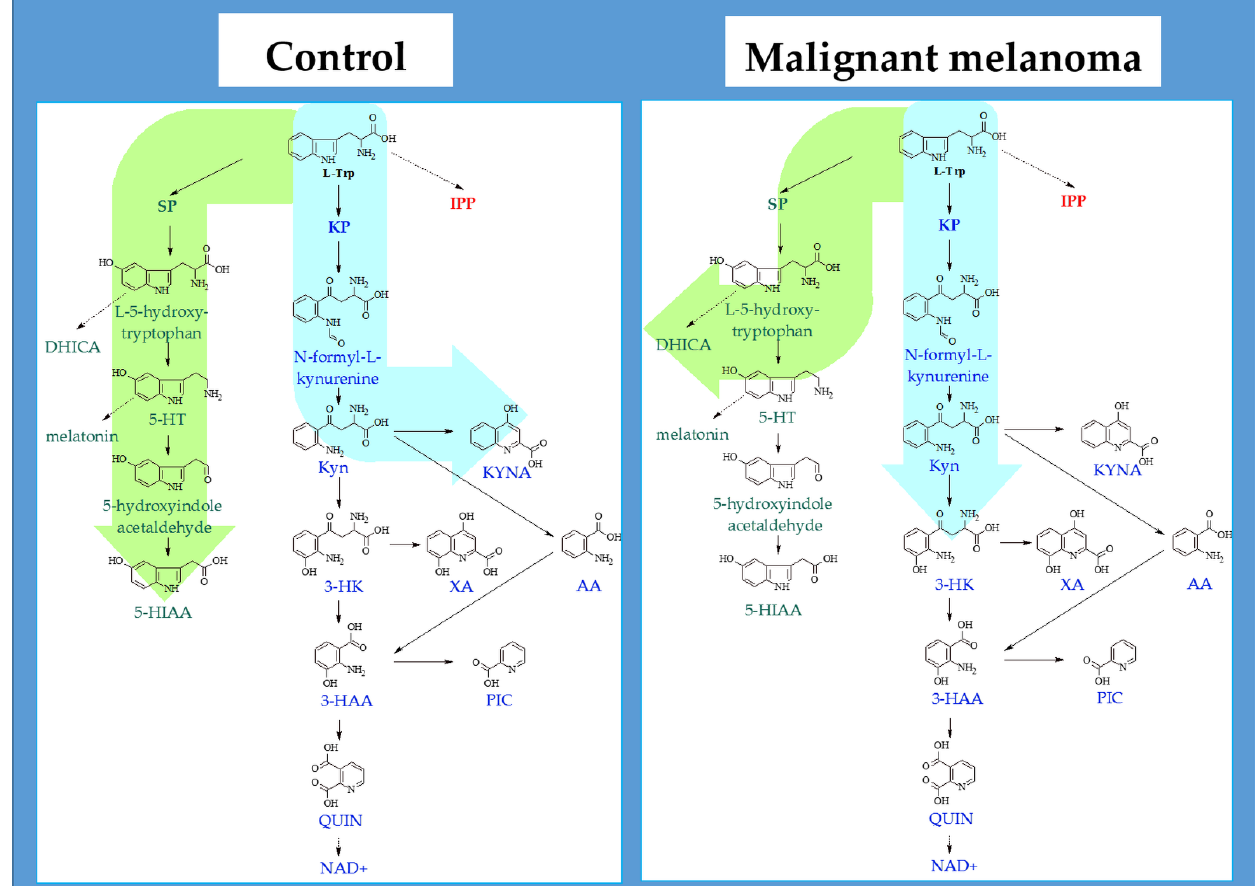
Figure 2. Comparison of the metabolization of the selected intermediates of the kynurenine, serotonin, and the indole pathway in malignant melanoma and in healthy control group. KP — kynurenine pathway, SP — serotonin pathway, IPP — indole pyruvate pathway; L-Trp — L-tryptophan, Kyn — kynurenine — intermediate in NAD + biosynthesis but also neurotoxic intermediates 3-HK and QUIN, 3-HK — 3-hydroxykynurenine, 3-HAA — 3-hydroxyanthranilic acid, QUIN — quinolinic acid, NAD + — nicotinamide adenine dinucleotide, KYNA — kynurenic acid — product of KP branch, neu- roprotective compound, AA — anthranilic acid, XA — xanthurenic acid, PIC — picolinic acid, 5-HT —